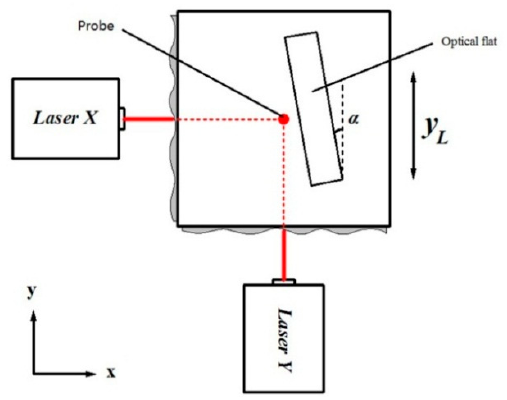
Figure 7. Schematic diagram of the surface flatness calibration of X ‐ interferometer’s reflection mirror.